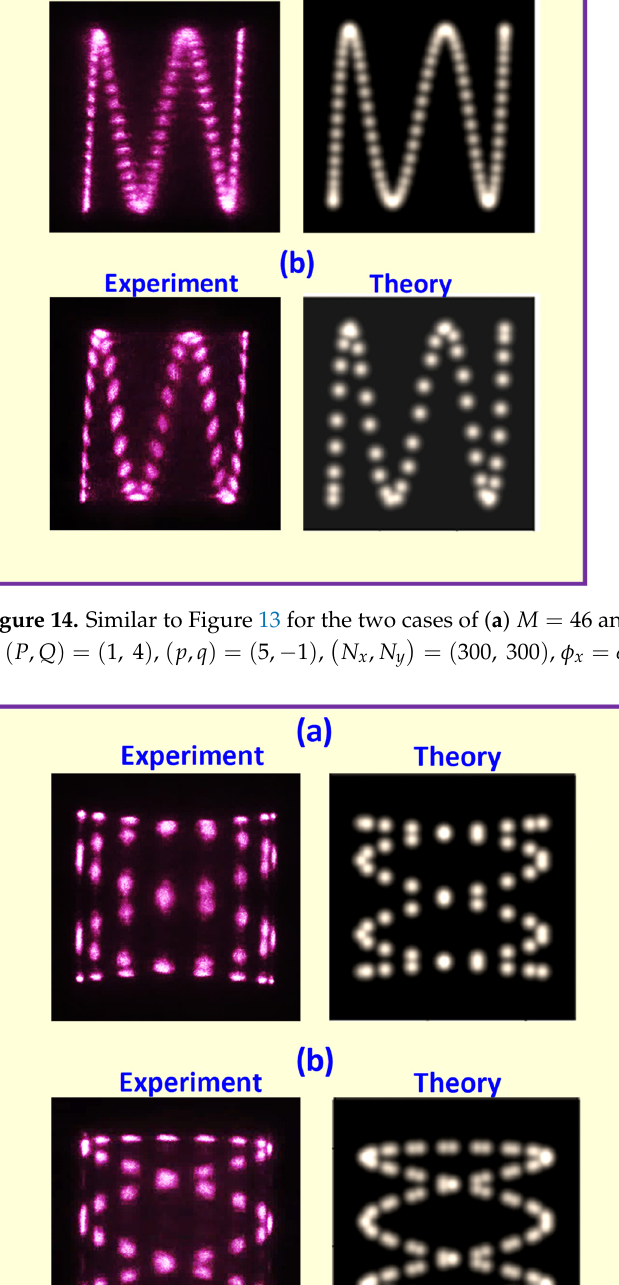
Figure 13. Experimental and theoretical far-field transverse patterns for the cases of ( a ) 𝑀 = 100 Figure 15a,b are the same except for φ x = φ y = π /4. Once again, all theoretical results are and ( b ) 𝑀 = 101 to manifest the influence of the factor 𝐶 (cid:3031) with (𝑃, 𝑄) = (1, 4) , (𝑝, 𝑞) = (1, 7) , (cid:3435)𝑁 (cid:3051) ,𝑁 (cid:3052) (cid:3439) = (500, 300) , 𝜙 (cid:3051) = 𝜙 (cid:3052) = 0, 𝑚 = 1 . in good agreement with experimental patterns.